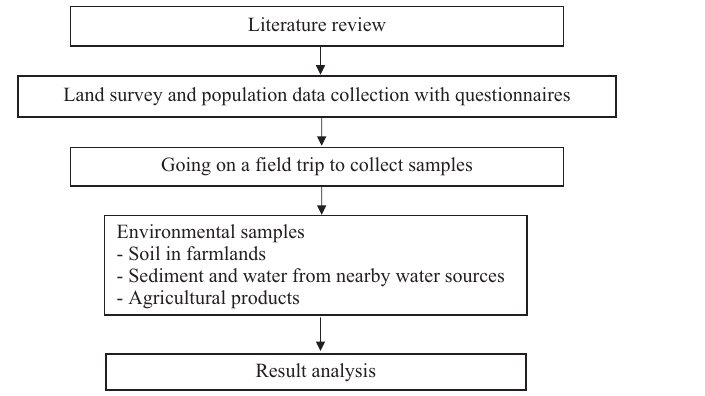
Figure 1. Methodology